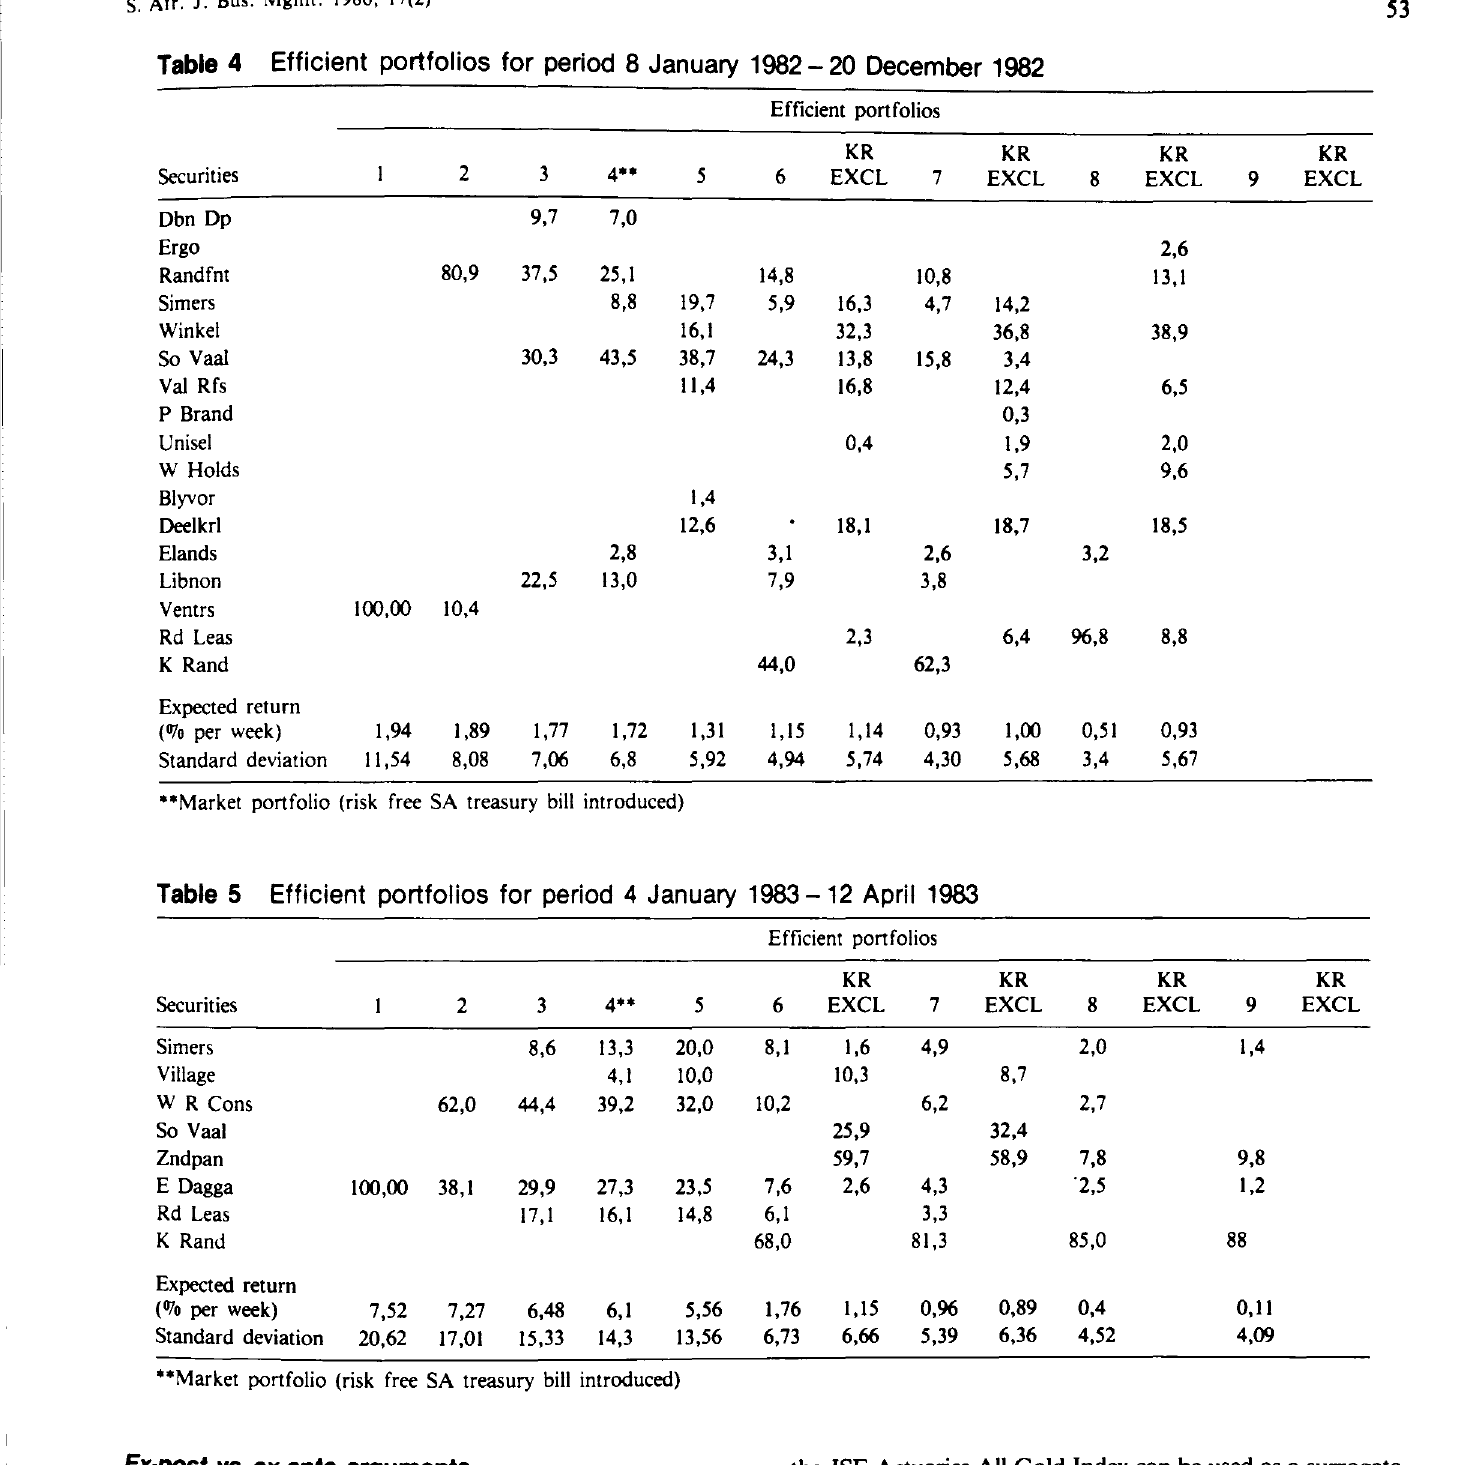
Efficient portfolios for period 8 January 1982-20 December 1982